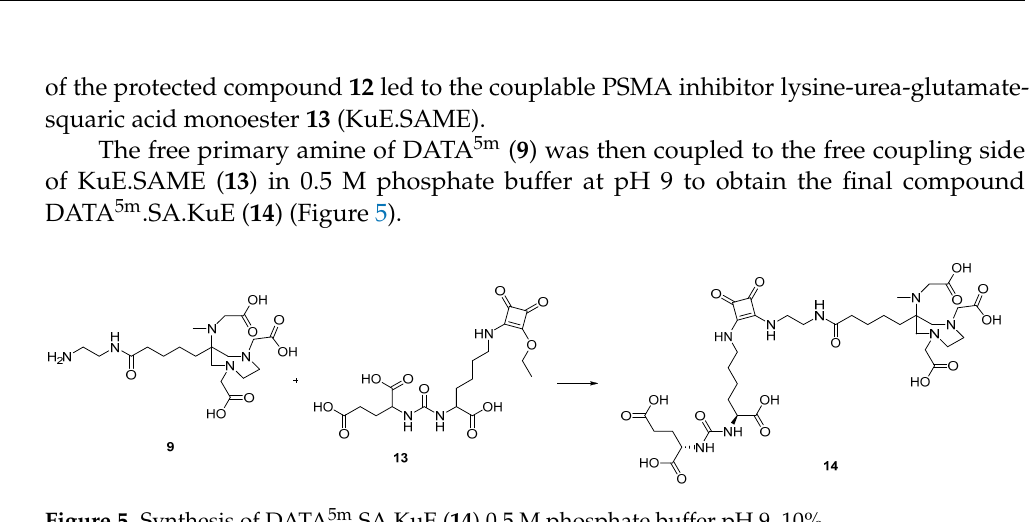
Figure 5. Synthesis of DATA 5m .SA.KuE ( 14 ) 0.5 M phosphate buffer pH 9, 10%.